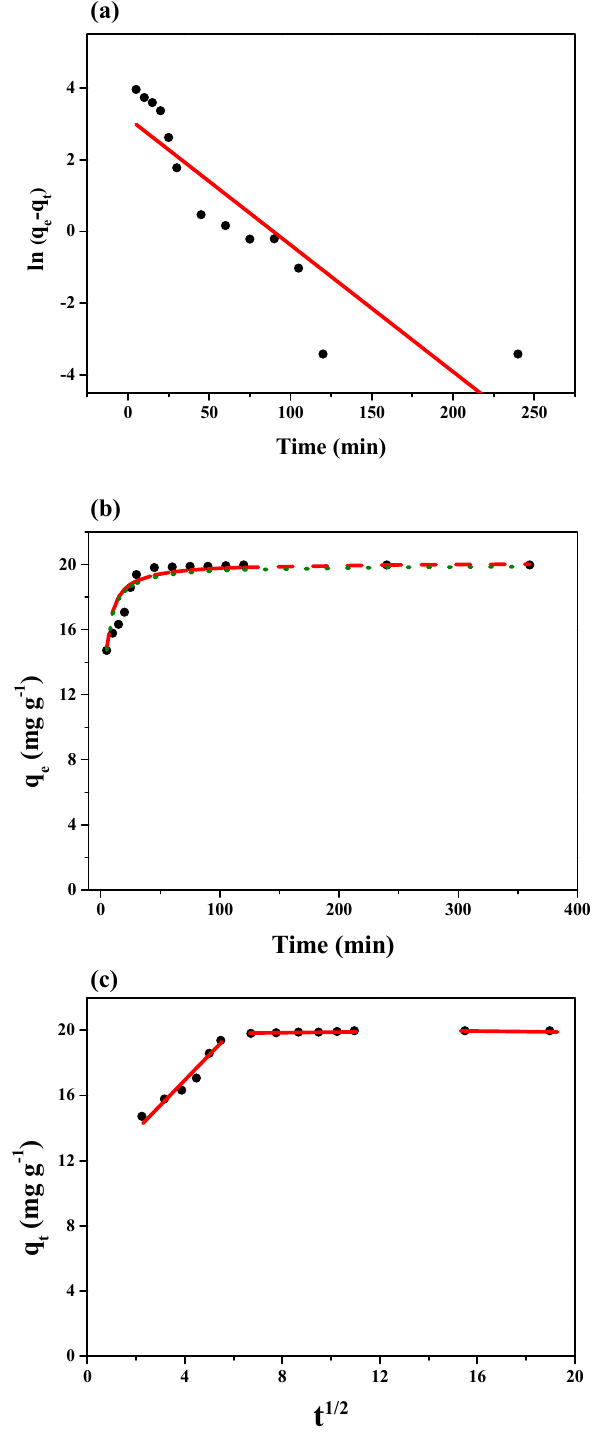
Figure 4. ( a ) Pseudo first order, ( b ) comparison of the estimation of linear and non-linear regressions of pseudo-second order model for Tu–N–SCG–C–A (red dash line: non-linear regressions; green dot line: linear regressions) ( c ) adsorption kinetics of intraparticle diffusion model (operating conditions: 250 mg of biocarbons and 50 mL of 50 mg L −1 Pt(IV) solution, pH =